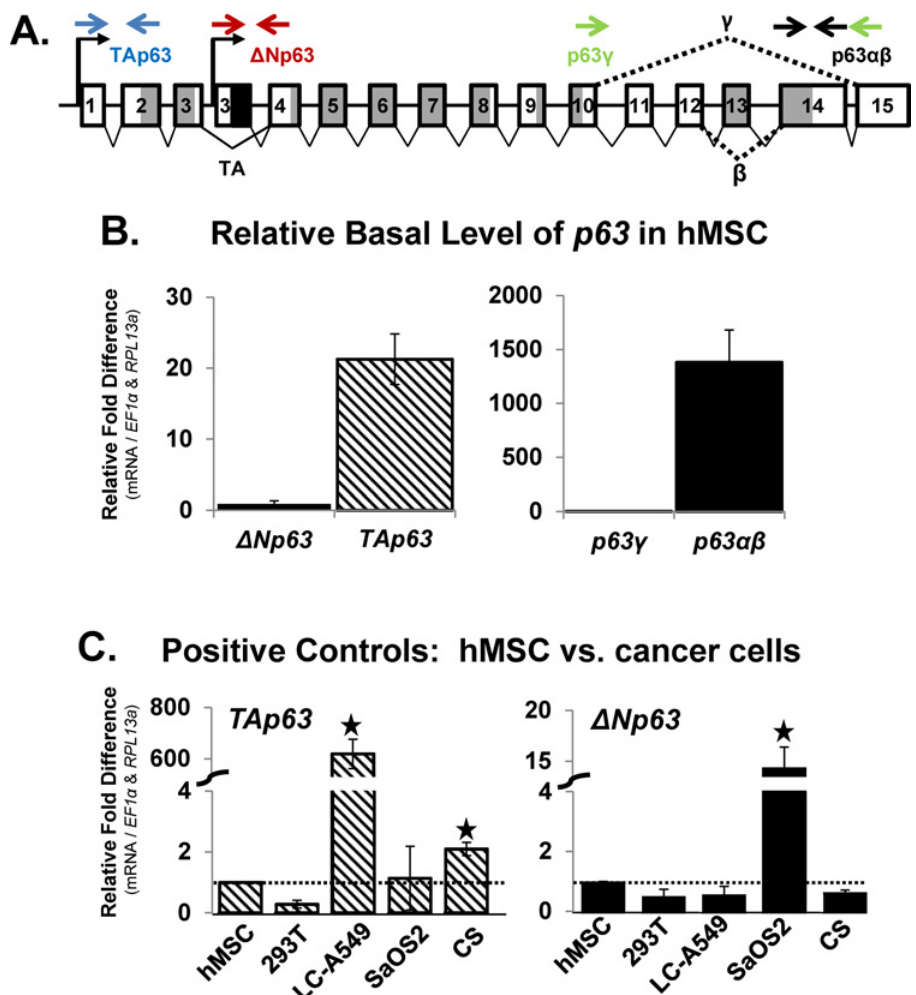
Fig 1. TAp63 α and - β are the predominant endogenous p63 gene products in naive hMSC. A) Schematic diagram (modified from [38]) depicting the p63 gene structure with the exons numbered sequentially and the relative location of primer pairs versus p63 exons used for RT-qPCR analysis of mRNA expression of the p63 mRNA isoforms ( TA- and Δ Np63 ) and splice variants ( p63 α / β and p63 γ ). B) hMSC were seeded at low-density (1,000 cells/cm 2 ) and grown under expansion conditions to maintain the pool of naive hMSC. RT-qPCR analysis of mRNA expression of the p63 isoforms (left panel; TA- and Δ Np63 ) and splice variants (right panel; p63 α / β and p63 γ ) under expansion conditions, expressed as relative fold difference. The real-time calculated PCR primer pair efficiency was calculated for each primer pair set in order to compare the relative fold difference in p63 variant expression in hMSC. C) RT-qPCR analysis of mRNA expression comparing hMSC versus various cancer cell lines was used to validate p63 primer pair sets and compare p63 expression in hMSC versus known expression in cancer cells as a positive control. Cell lines: human embryonic kidney (293T), non-small cell lung cancer (LC-A549), osteosarcoma (SaOS2); chondrosarcoma primary cell culture (CS). N = 3 independent experiments in triplicate. ( * ) p (cid:1) 0.05 compared to (B) left panel: Δ Np63 , right panel: TAp63 or (C) hMSC, which were set to the value of “ 1 ” . hMSC used were from a 7 and 22 year old